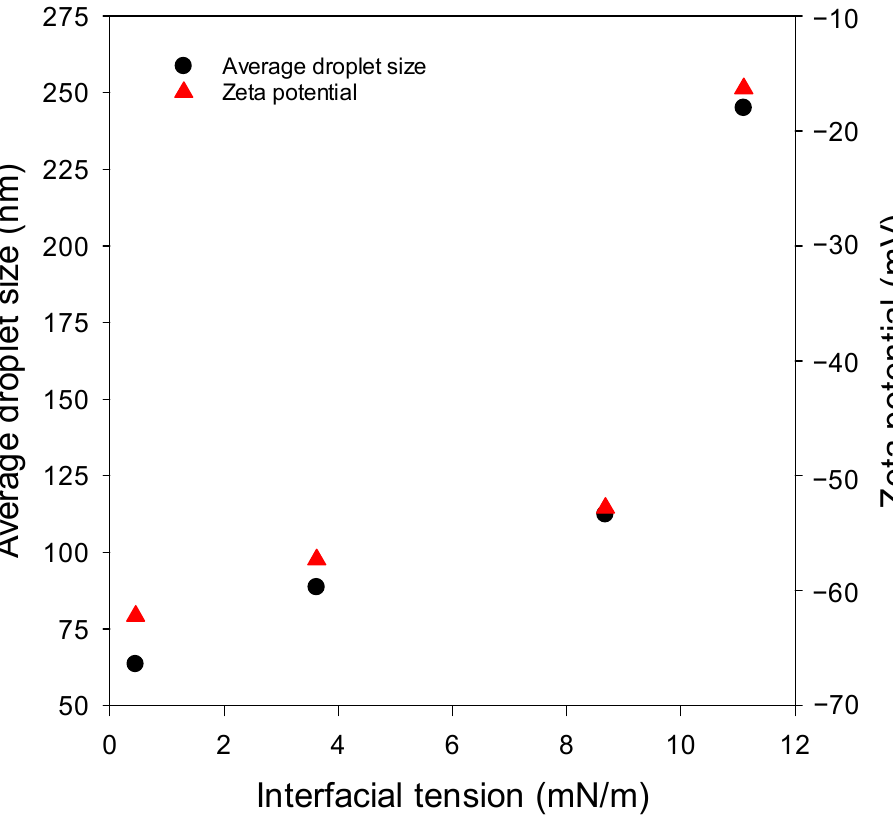
Figure 4. The “approximately” exponential-like correlation between IFT and the average droplet size and also between IFT and zeta potential of the formulated O/W nanoemulsions.